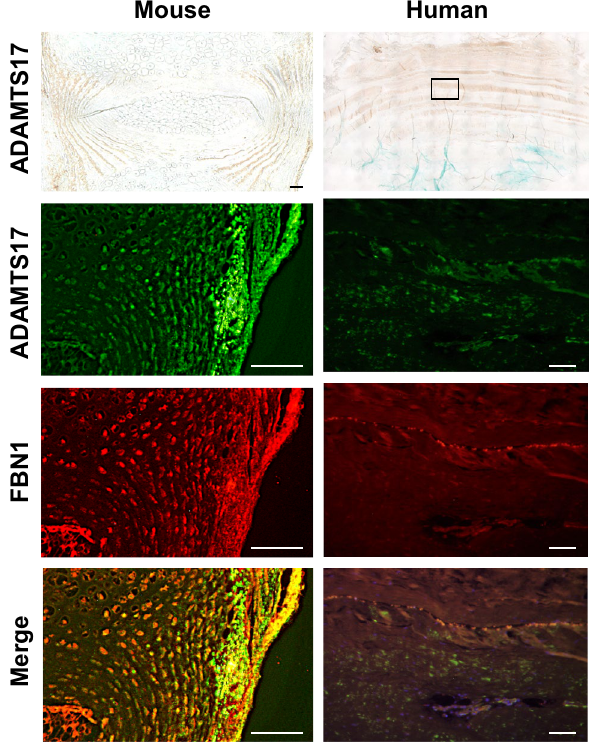
Figure 3. Immunohistochemistry and immunofluorescence images of ADAMTS17 and FBN1 in mouse and human intervertebral discs. Immunohistochemistry (the upper row) and immunofluorescence (the other rows) of ADAMTS17 and FBN1 in intervertebral disc (IVD) sections demonstrated the colocalized expression of Adamts17 and Fbn1 in annulus fibrosus of mouse (left) and human (right) IVDs. For mouse IVD sections, we used lumbar spinal IVDs obtained from C57/B6 mice of postnatal day 14 (P14). Non-degenerated human IVD samples were obtained from an 18-year-old patient during surgery for idiopathic scoliosis. Scale bar, 100